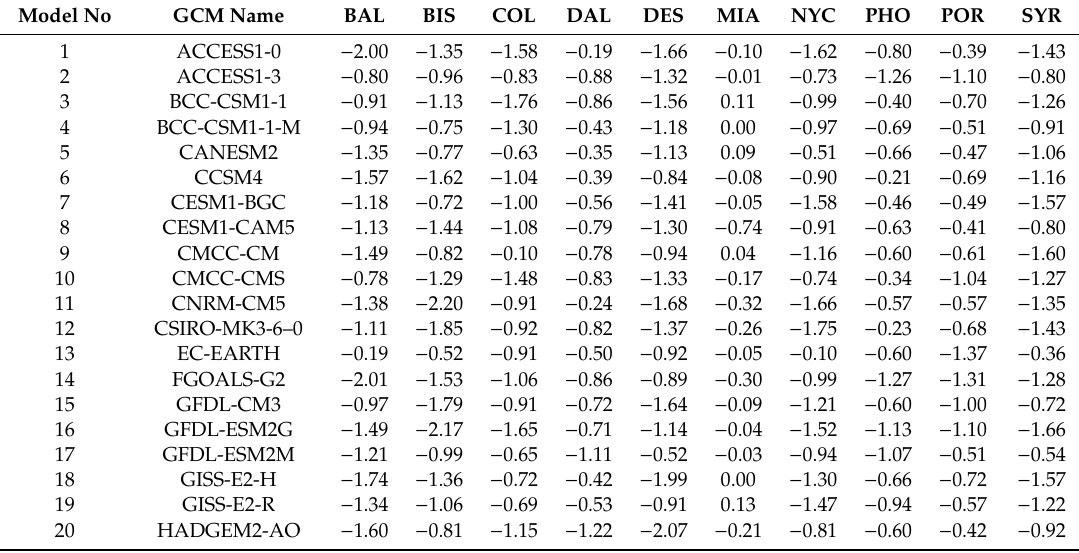
Table A5. NSE coe ffi cient of Days between observed and simulated data